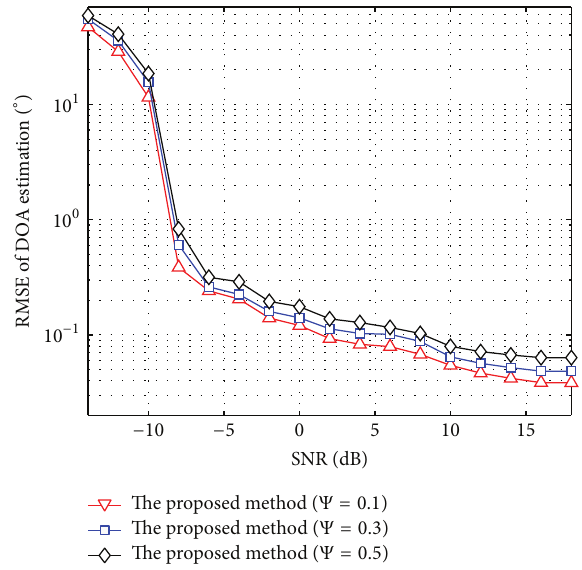
Figure 4: RMSE of the DOA estimates versus input SNR with different angle resolution